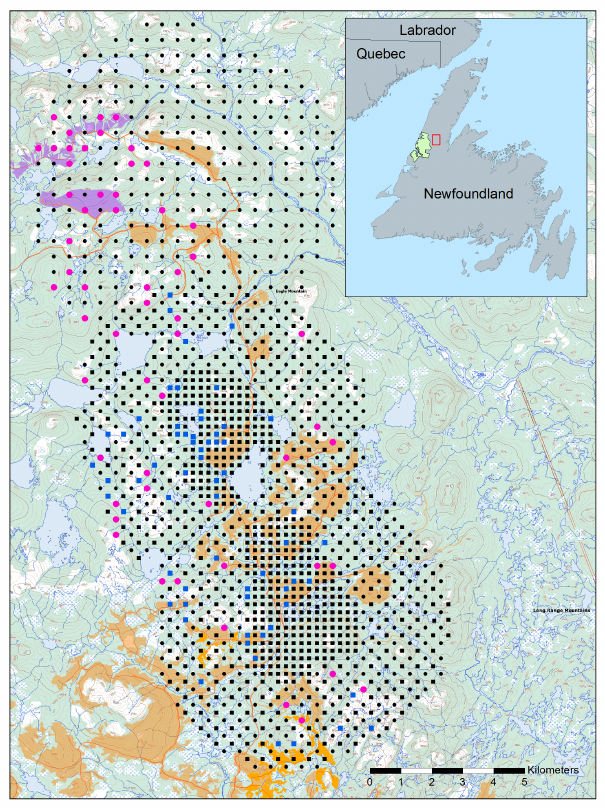
Fig. 2 . Distribution of survey points in the upper Main River and Humber River watersheds in western Newfoundland. Points sampled in 2006 are depicted with circles, while those sampled in 2007 are illustrated using squares. Points where Gray-cheeked Thrushes (Catharus minimus minimus) were observed are depicted with pink circles (2006) and blue squares (2007). Clearcuts are depicted in orange, and modified harvest blocks are shown in purple. The red box on the inset map shows the location of the study area on the island of Newfoundland, and Gros Morne National Park is depicted in